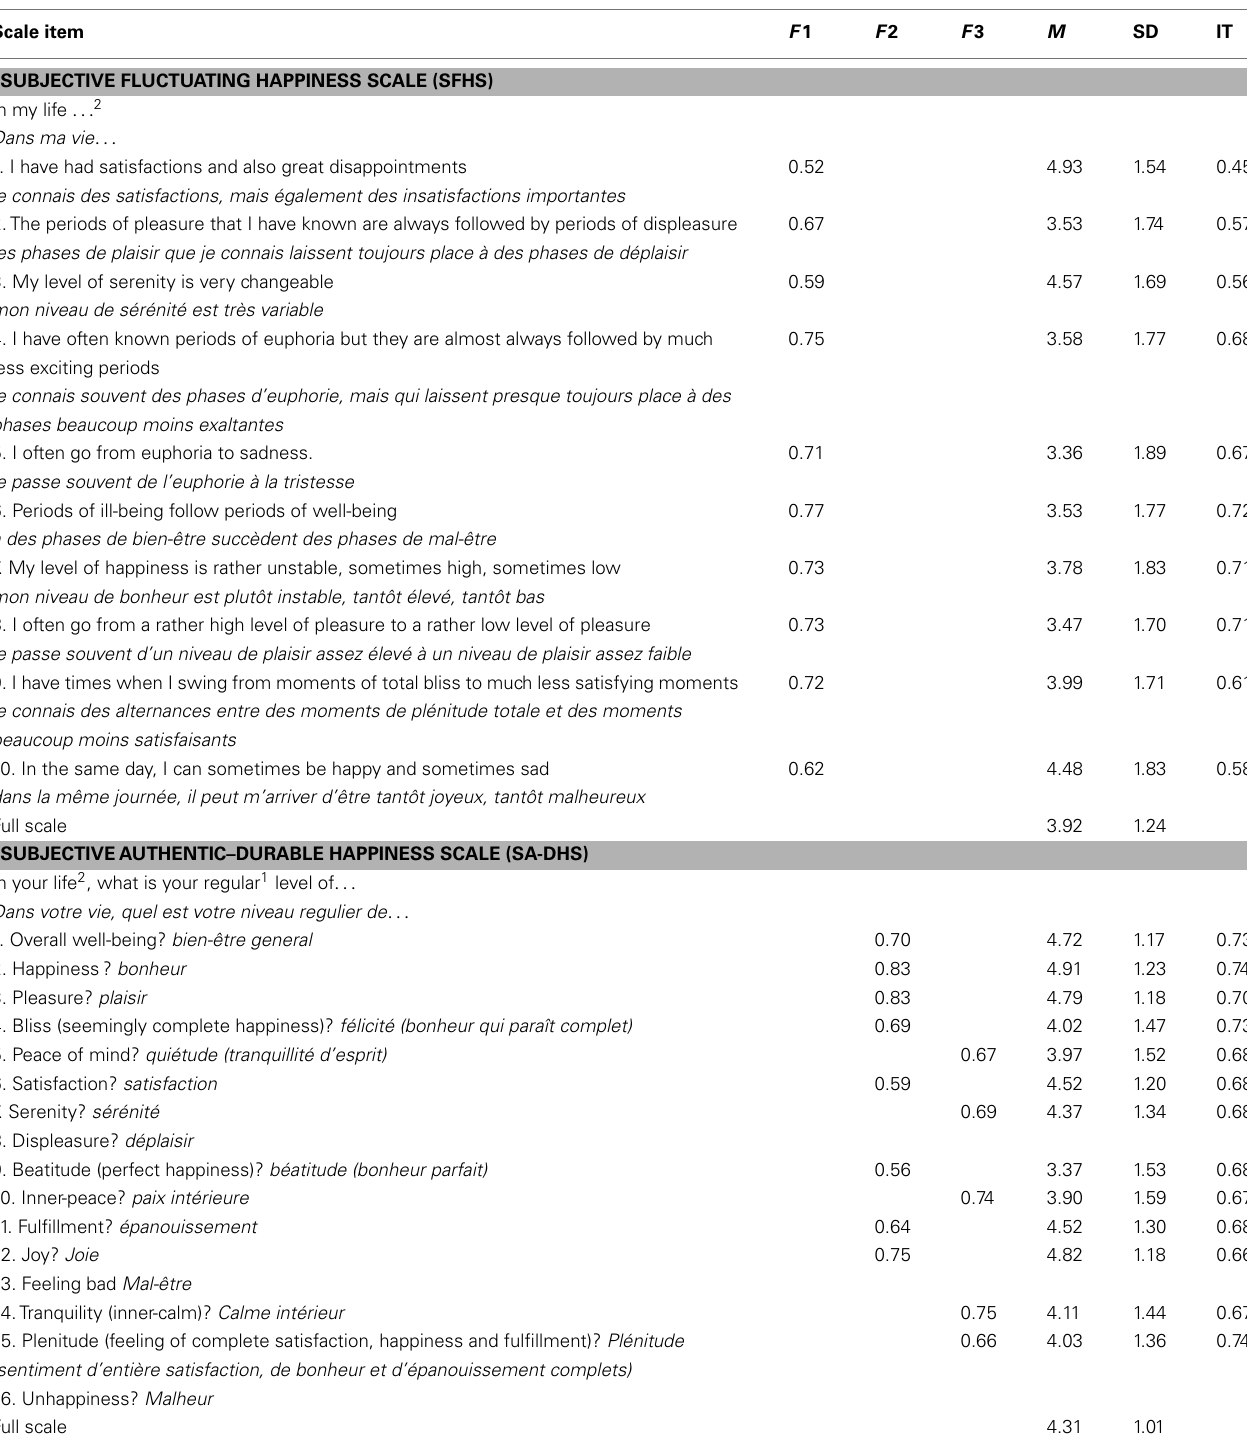
Table 1 | Factor loadings, means, SDs, and item-total correlations. Scale